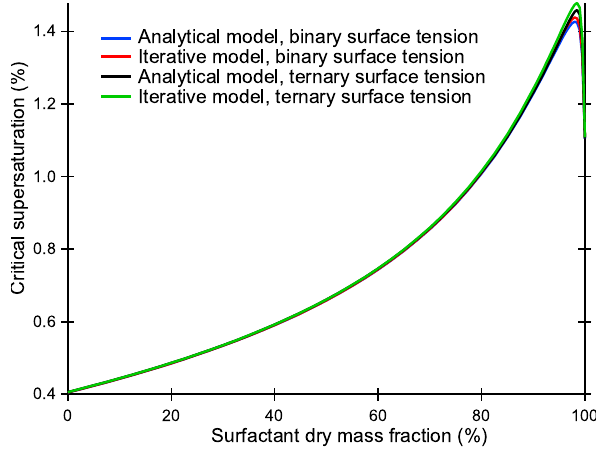
Fig. 3. Critical supersaturation for 40nm SDS-NaCl particles as a function of dry particle surfactant mass fraction. Model predictions are made with the analytical and iterative models with both binary and ternary surface tension parameterizations.